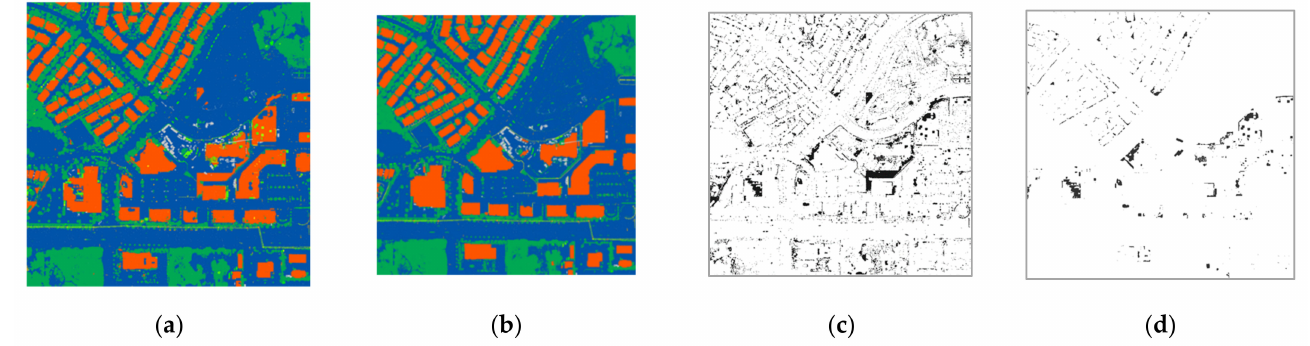
Figure 16. Results of semantic segmentation of test data 1 for case 1: ( a ) prediction; ( b ) ground truth (i.e., label data); ( c ) difference between prediction and ground truth for all classes; ( d ) difference between prediction and ground truth for building class only.